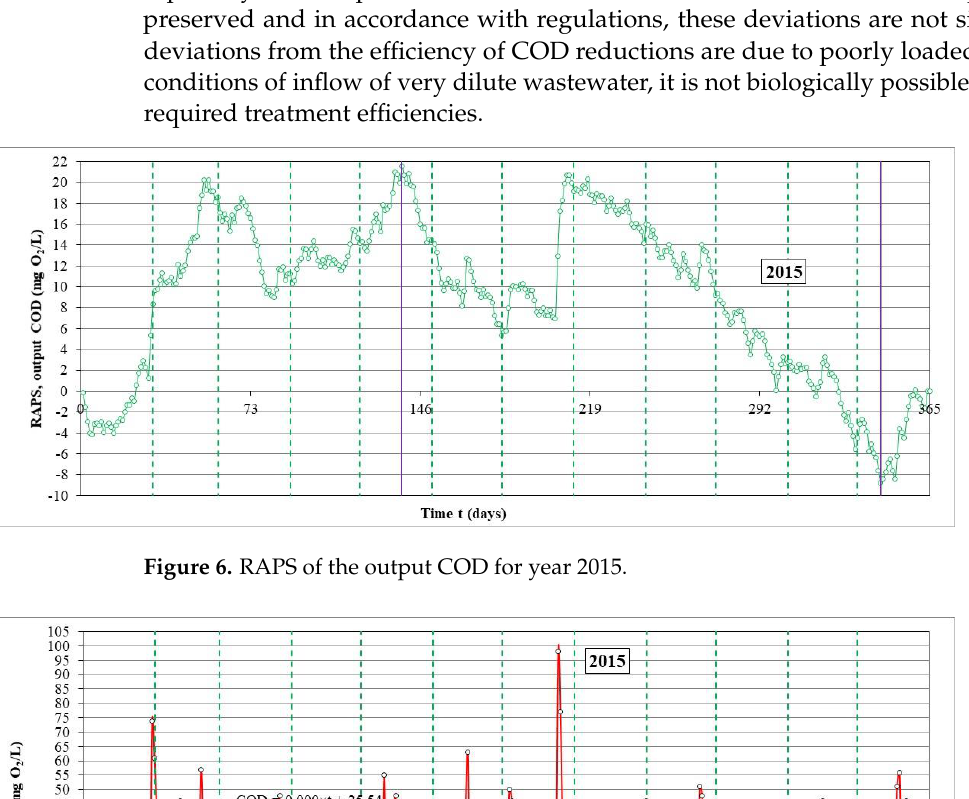
Figure 5. Output of COD for year 2015.